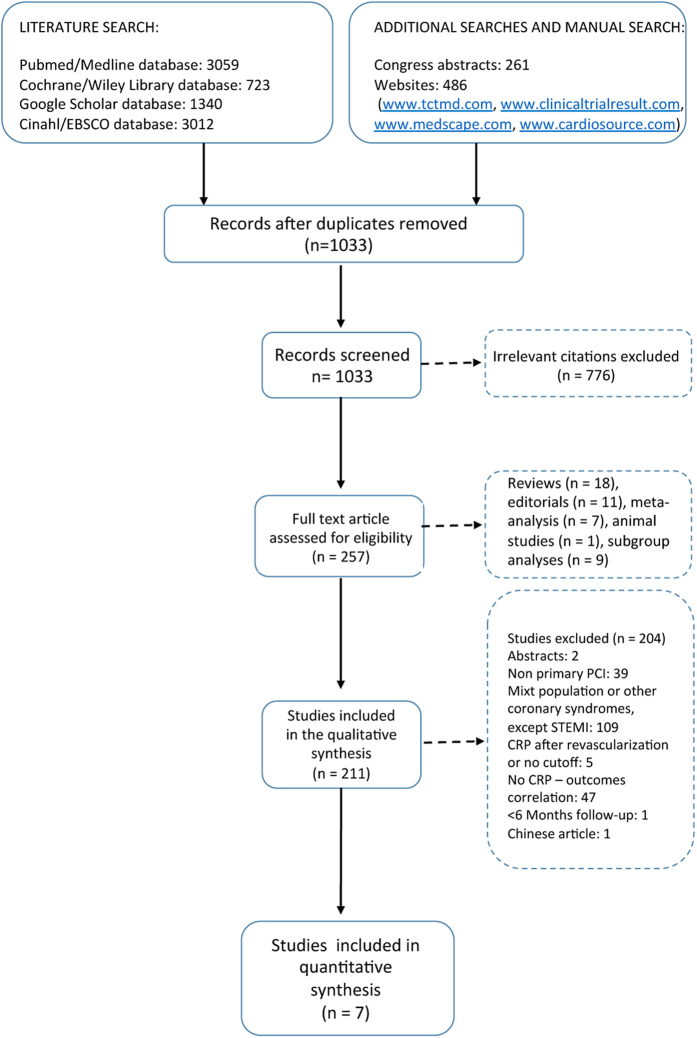
PRISMA selection flowchart47.